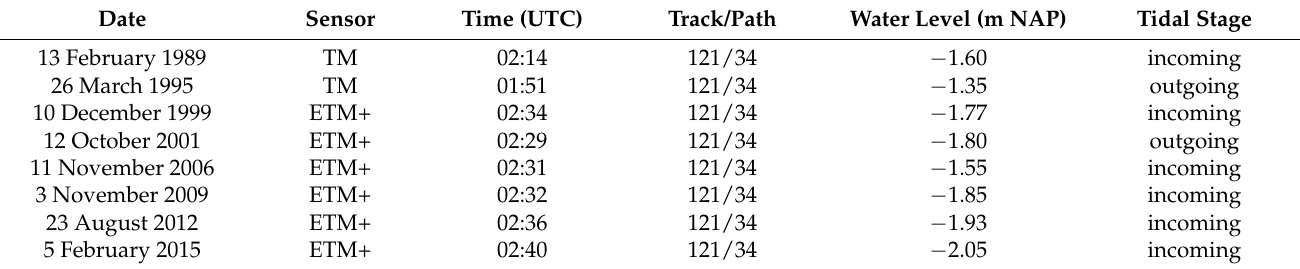
Table 1. Specification of the Landsat imagery used in this